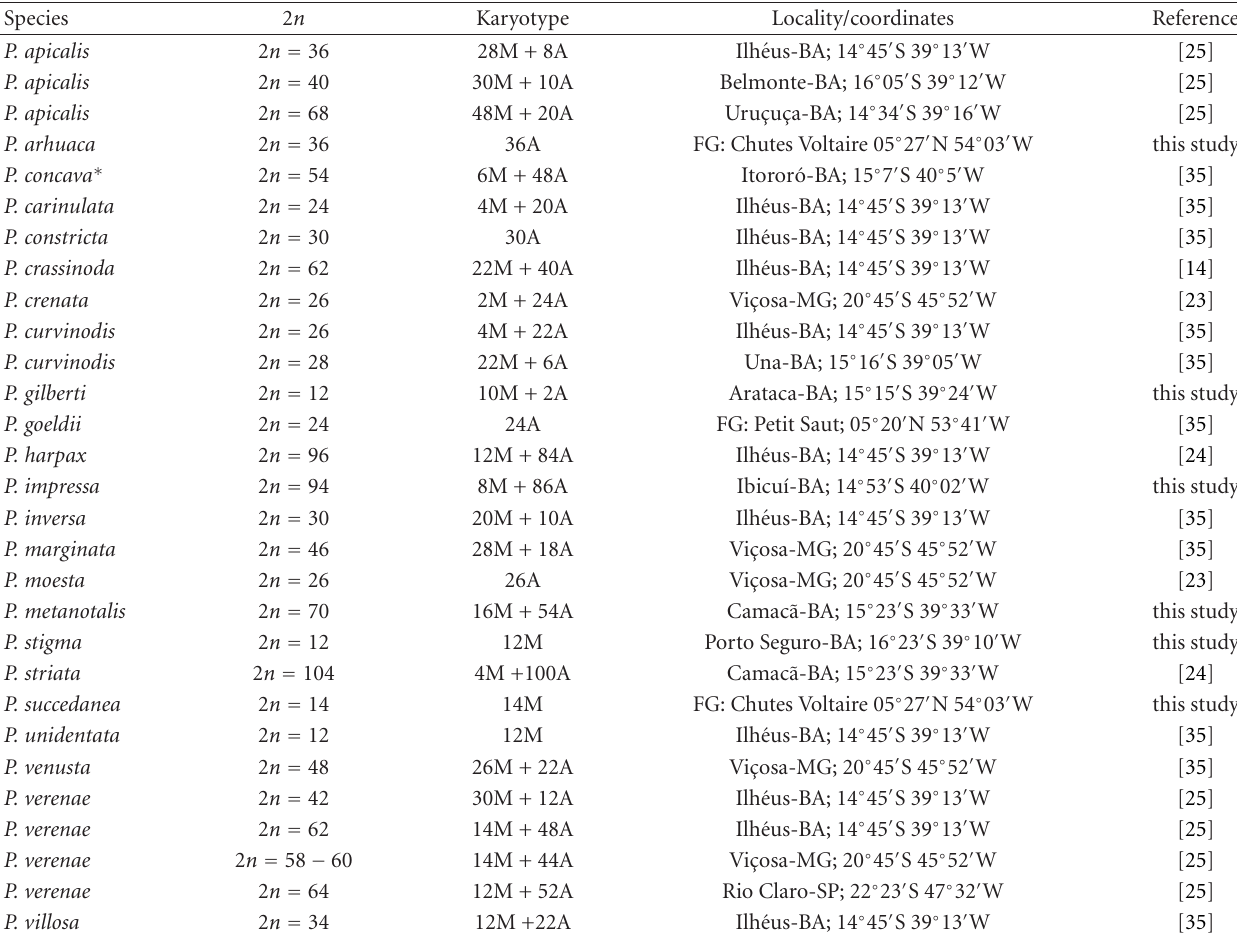
Table 2: Chromosome number and karyotypes of 29 Neotropical Pachycondyla populations/species. FG: French Guyana, others: Brazil: BA: state of Bahia, MG: state of Minas Gerais, SP: state of S˜ao Paulo. ∗ Referred to as P. gp. venusta in the original